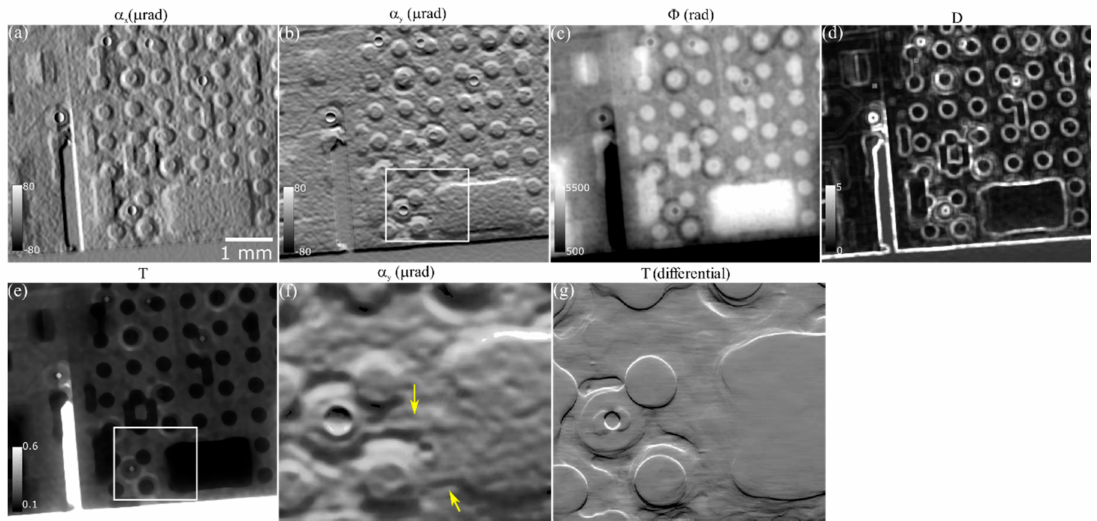
Figure 2. The multimodal images of a chip retrieved from the speckle-based imaging method: ( a ) refraction angle in horizontal and ( b ) in vertical direction, ( c ) phase shift ( d ) dark-field signal and ( e ) transmission image. ( f ) shows the refraction angle in vertical direction of the zoomed region in ( b ), and ( g ) is the transmission signal differentiated in vertical direction from the region of interest from ( e